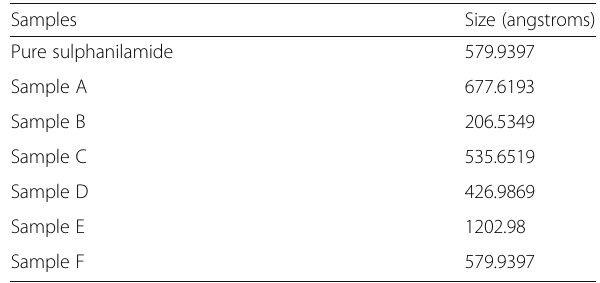
Table 3 Size of crystallite obtained by solvent evaporation method from Table 2